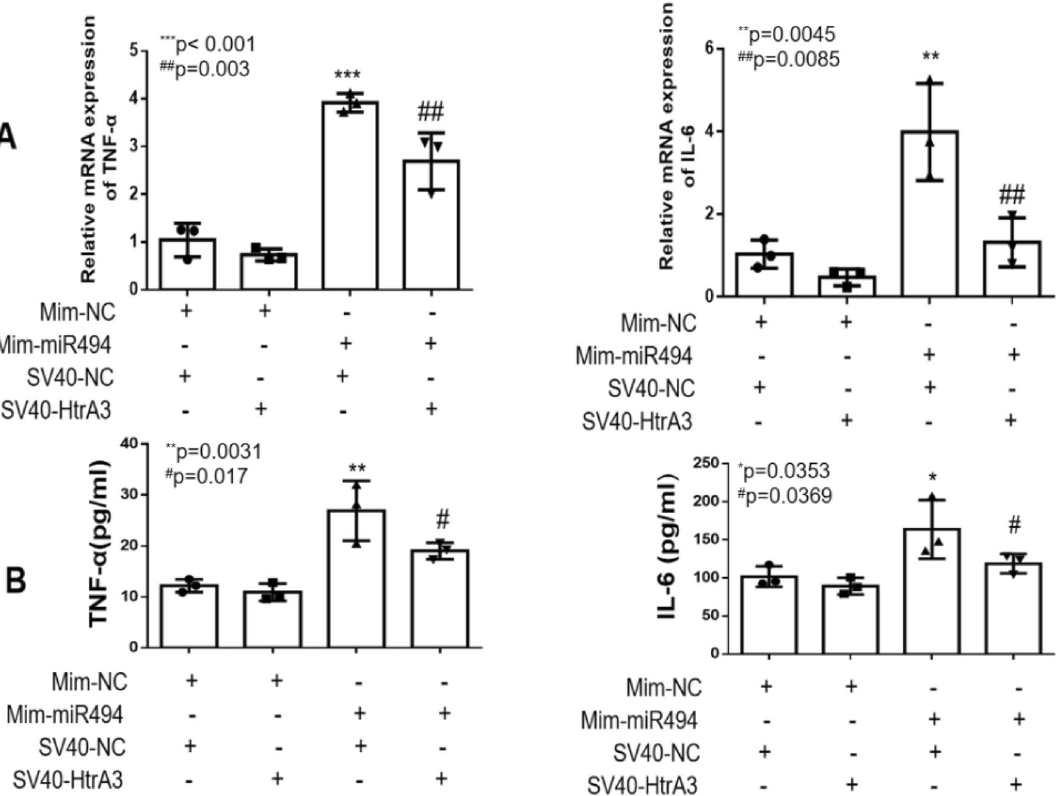
Figure 8. Hsa-miR-494-3p mimics-induced inflammatory response was inhibited by overexpression of HtrA3. ( A ) Real-time PCR data show overexpression of HtrA3 decreased hsa-miR-494-3p mimics-induced mRNA of TNF-α and IL-6; ( B ) ELISA data show overexpression of HtrA3 decreased hsa-miR-494-3p mimics-induced TNF-α and IL-6 protein level; N (the replicate for above experiments) = 3. *P < 0.05, **P < 0.01, ***P < 0.001, versus control. # P < 0.05, ## P < 0.01, ### P < 0.001, versus SV40-NC